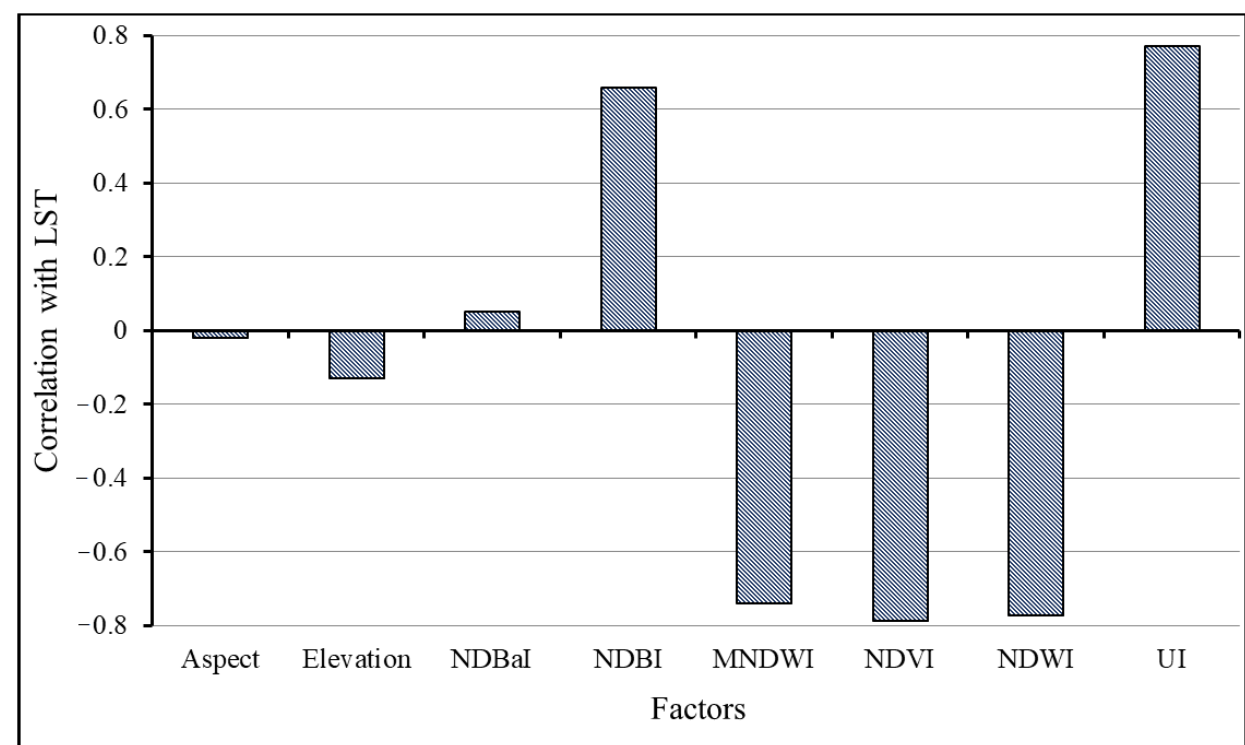
Figure 6. City scale correlation of LST and land surface characteristics in Harare.